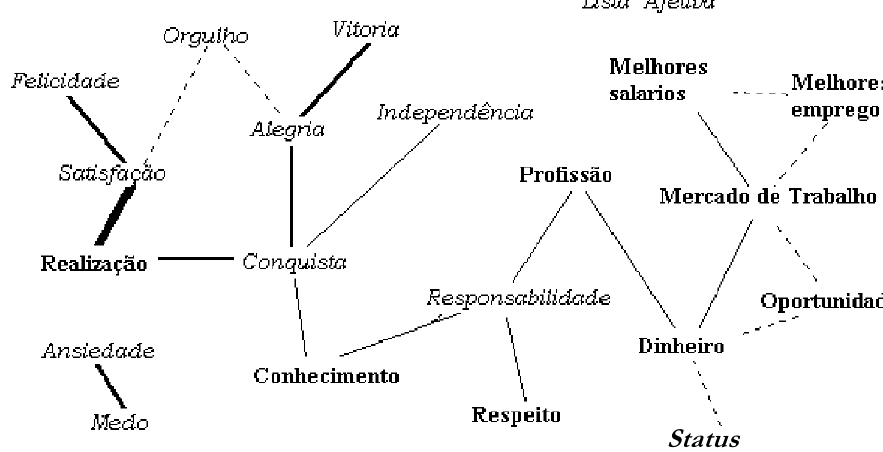
Figura 2. Organiza(cid:231)ªo dos elementos da representa(cid:231)ªo social de diploma